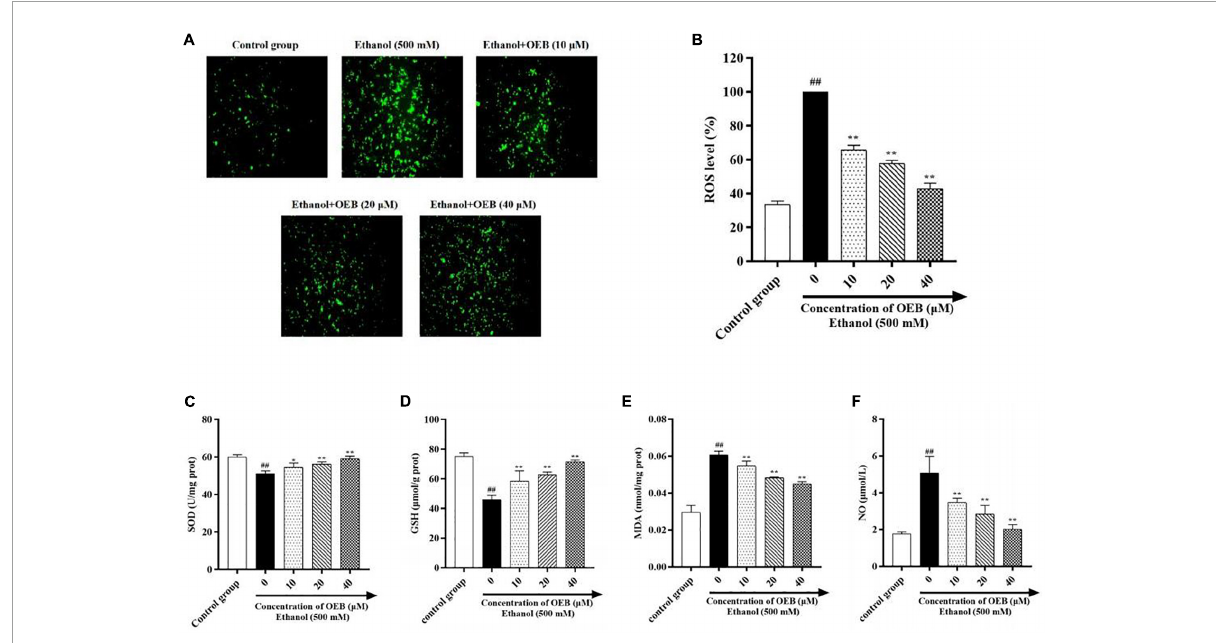
FIGURE2 OEB suppressed ethanol-induced oxidative stress in HepG2 cells. Cells were pretreated with OEB (10, 20, and 40 µ M) for 6 h, followed by ethanol (500 mM) for 24 h. (A) ROS levels in HepG2 cells monitored by confocal fluorescence microscopy imaging of DCF fluorescence intensity. (B) ROS levels were evaluated in HepG2 cells. The levels of (C) SOD, (D) GSH, and (E) MDA in cell homogenate and (F) NO in cell supernatant were evaluated. Data represents mean ± SD ( n = 5). ## P < 0.01 with respect to the control group; * P < 0.05 and ** P < 0.01 with respect to the model